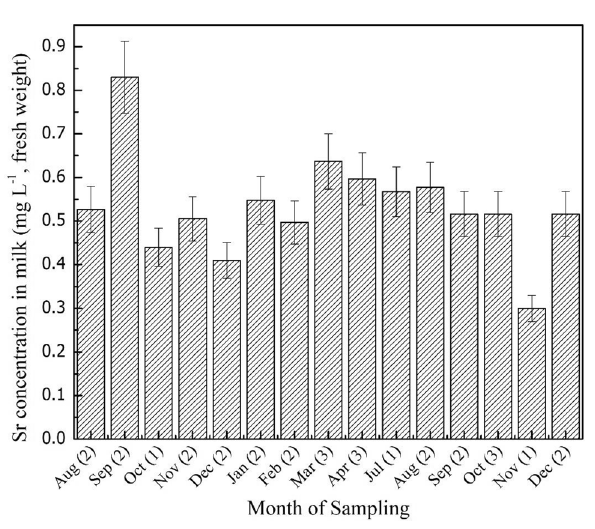
Figure 3. Monthly variation of stable Sr concentration in